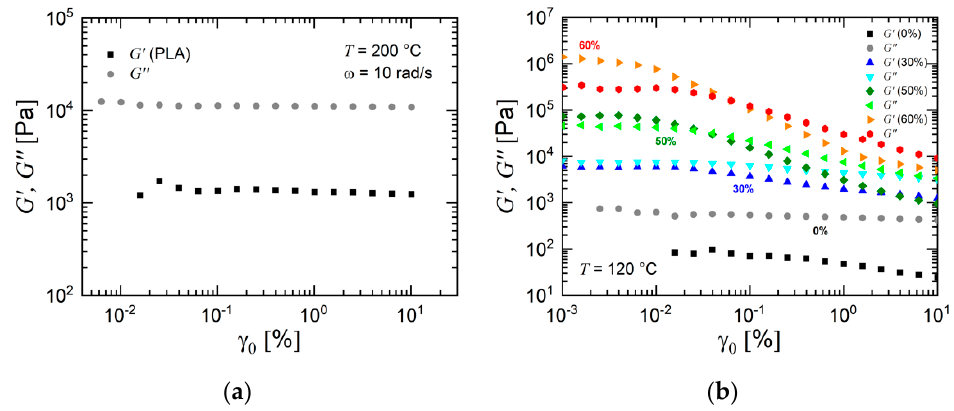
Figure 8. Strain sweeps at an angular frequency of ω = 10 rad/s for a polylactide and selected feedstocks of this study. ( a ) Polylactide at a temperature of 200 °C and ( b ) selected feedstocks at 120